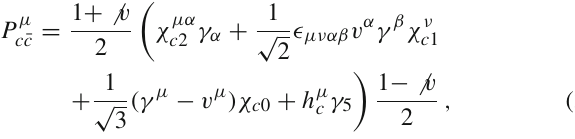
pairs were studied. The results indicate that the IML tran- sitions are important to reproduce the experimental data on these decays, although there are still some model-dependent parameters needed to be determined with more accurate data.